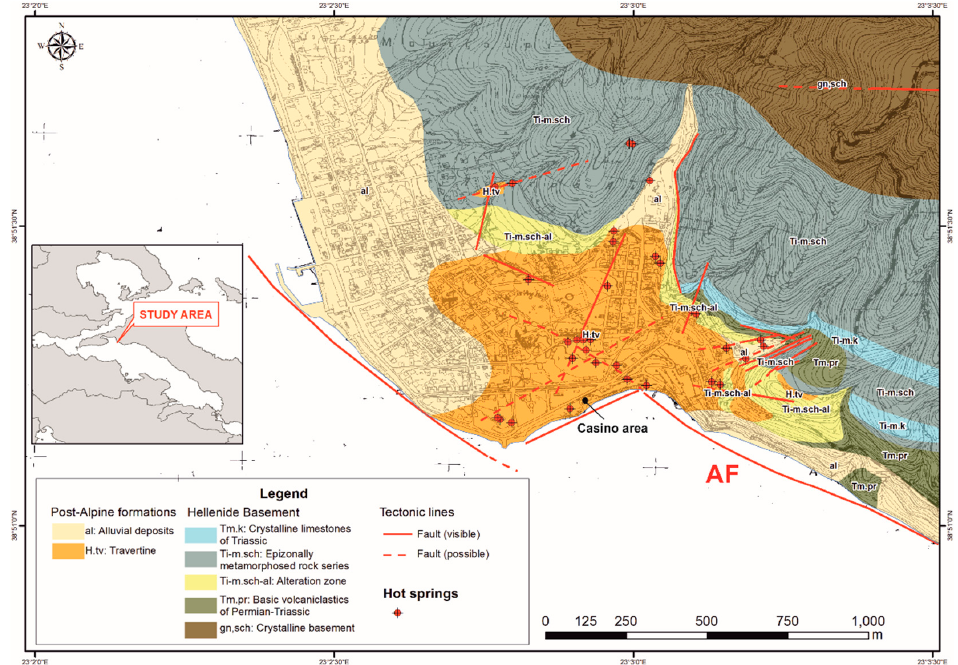
Figure 1. Geological map of the Aedipos area, NW of Euboea (AF = Aedipsos Fault); modified after Kanellopoulos et al. [40]. The sampling site is located in the Casino area, which is marked with a black dot. The geographical coordinates system is EGSA87.